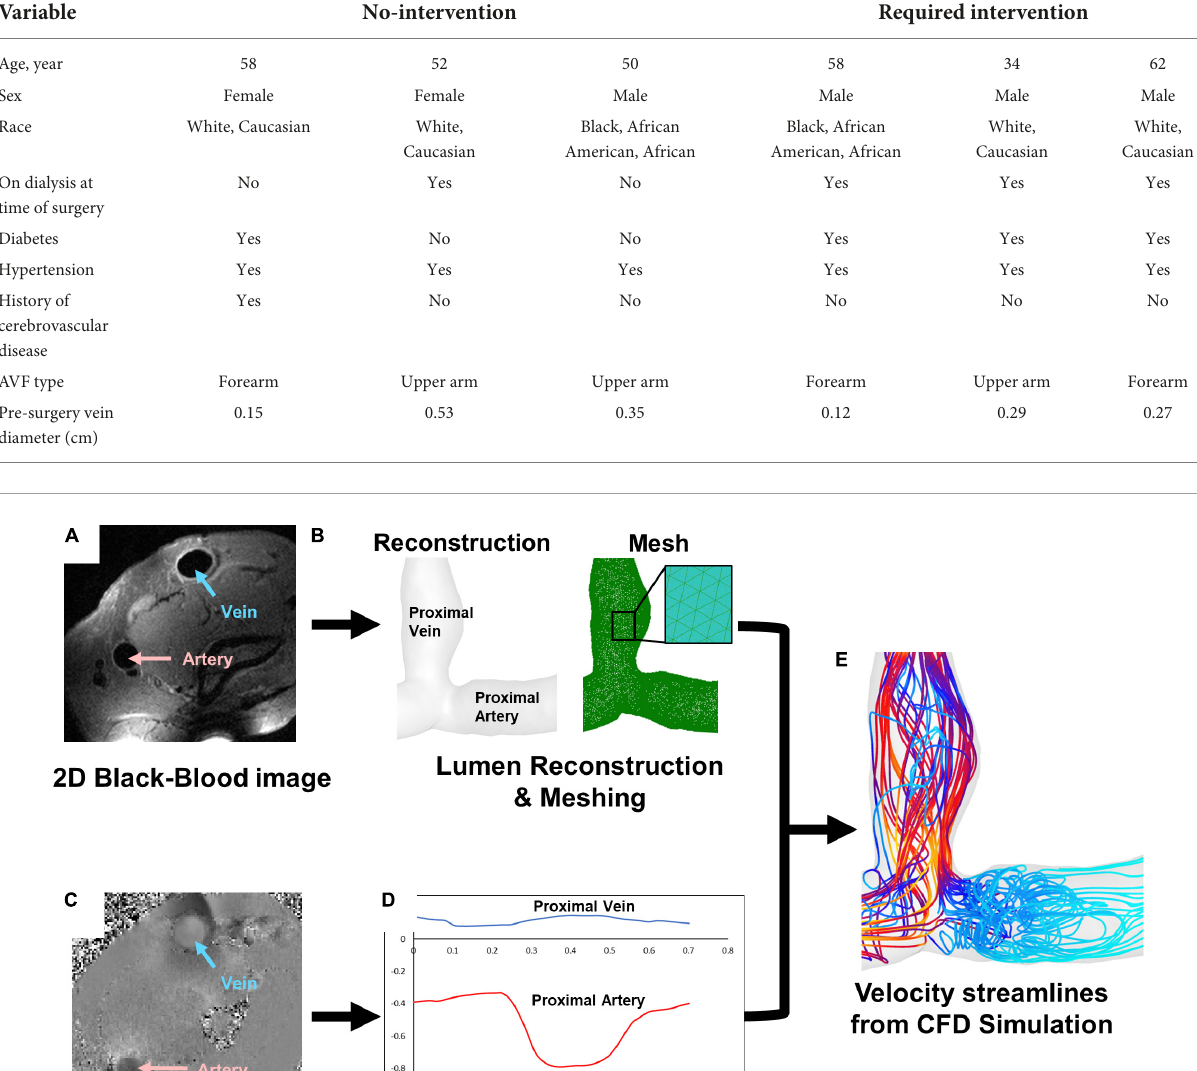
TABLE 1 Individual patient characteristics.